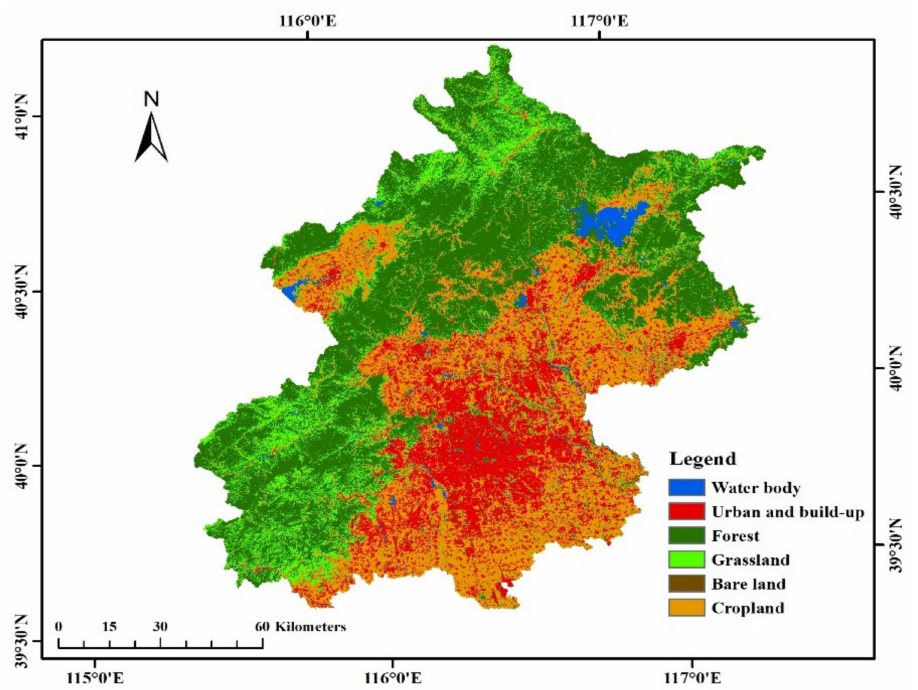
Figure 7. An application example of ARD: land cover classification result.